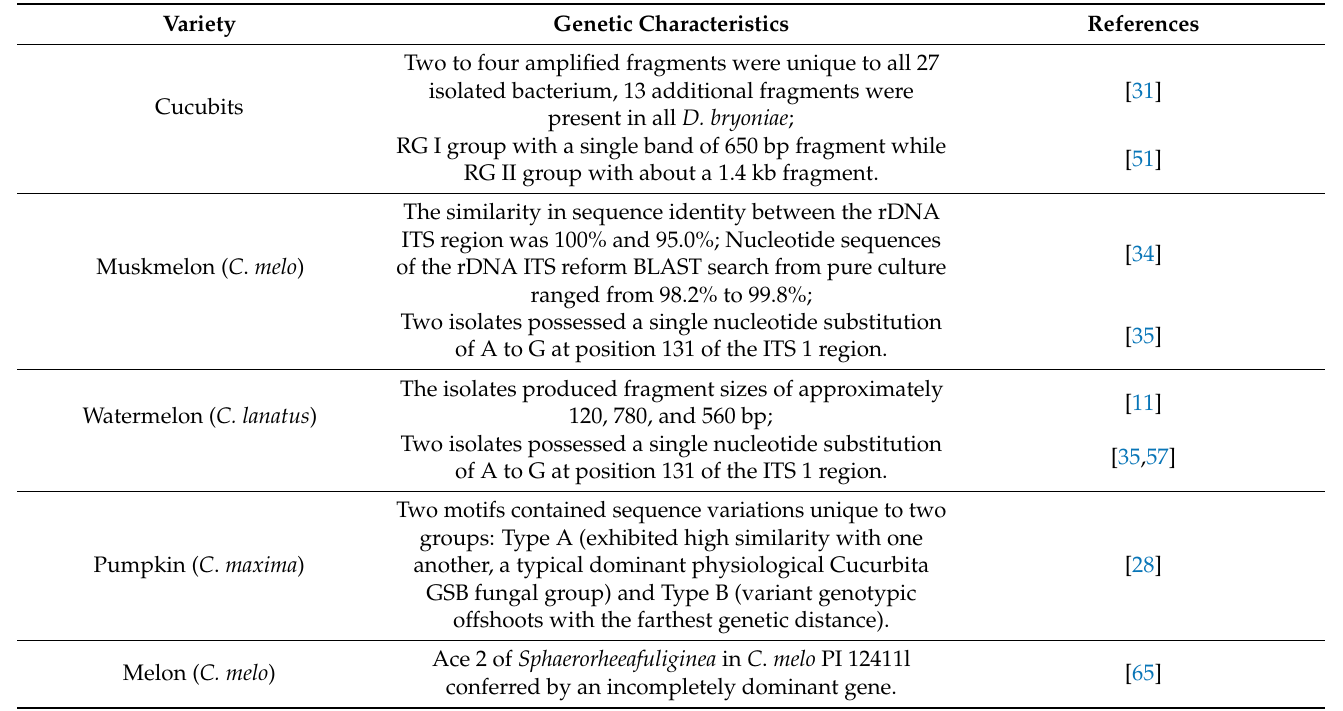
Table 2. Genetic characteristics of the fungus of GSB in various Cucurbitaceous vegetables. Genetic